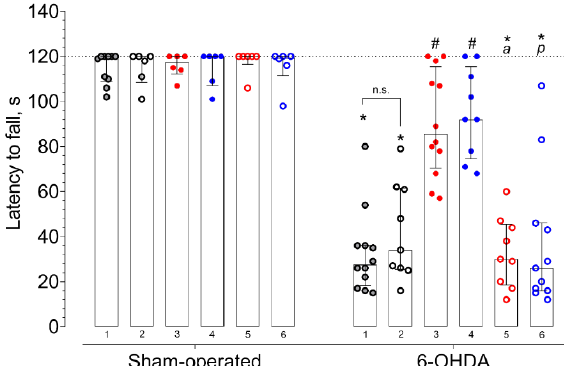
Figure 4. The influence of deferred administration of afobazole over 14 days on latency to fall during fixed-speed rotarod test (FSRR) in 6-OHDA-lesioned and sham-operated ICR mice. Data are presented as median with interquartile range. Sham-operated—sham-operated animals. 6-OHDA—animals with 6-OHDA lesion. Experimental groups were divided by treatment, drugs were administered 20 h prior to the test: 1 vehicle. 2 BD-1047 3.0 mg / kg. 3 afobazole 2.5 mg / kg. 4 PRE-084 1.0 mg / kg. 5 BD-1047 3.0 mg / kg and afobazole 2.5 mg / kg. 6 BD-1047 3.0 mg / kg and PRE-084 1.0 mg / kg. Kruskal-Wallis test, Dunn’s multiple comparison test: A significant di ff erence ( p < 0.05) was observed within all experimental groups except for afobazole (3) and PRE-084 (4). Statistical significance: * p < 0.01 vs. sham-operated vehicle-treated mice. # p < 0.01 vs. 6-OHDA-lesioned vehicle-treated mice. a p < 0.01 vs. 6-OHDA-lesioned afobazole-treated mice. p p < 0.05 vs. 6-OHDA-lesioned PRE-084-treated mice.